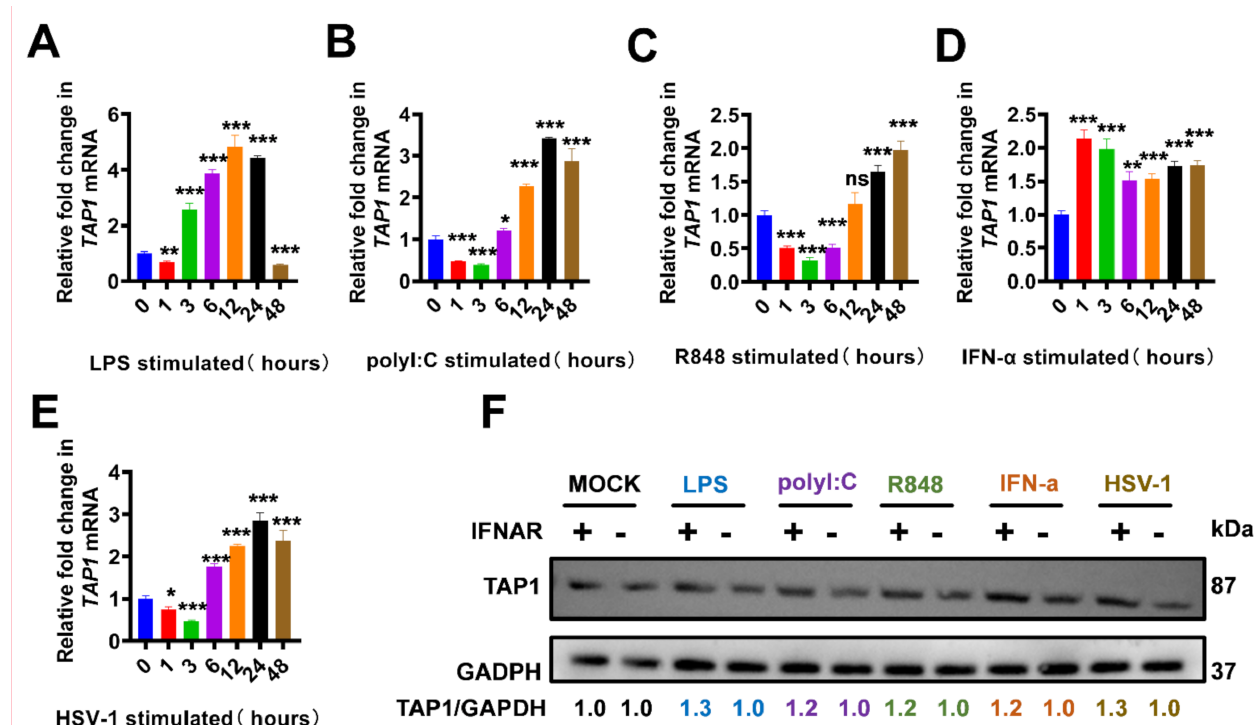
Figure 1. The upregulated TAP1 in response to Toll-like receptors (TLRs) agonists and viral infections. ( A – E ) Raw 264.7 cells were stimulated with LPS (1 µ g/mL), polyI:C (25 µ g/mL), R848 (100 nM), IFN- α (2000 U/mL), and HSV-1 (MOI = 0.25), respectively, and then the expression of TAP1 gene was measured by RT-qPCR at different timepoints. The expression level of mRNA was normalized to the expression of β -actin , and the data from at least triplicates were shown as the mean ± SD. * p < 0.05, ** p < 0.01, *** p < 0.001. ( F ) Wild type bone marrow-derived macrophage (WT-J2-BMM) cells or interferon α receptor-deficient ( IFNAR − / − )-J2-BMM cells were stimulated with LPS (1 µ g/mL), polyI:C (25 µ g/mL), R848 (100 nM), IFN- α (2000 U/mL), and HSV-1(MOI = 0.25) for 24 h, respectively, and then the expression of TAP1 protein was measured by Western blot analysis. GAPDH was used as intern control. The relative ratios of TAP1 and GAPDH were marked at the bottom of the